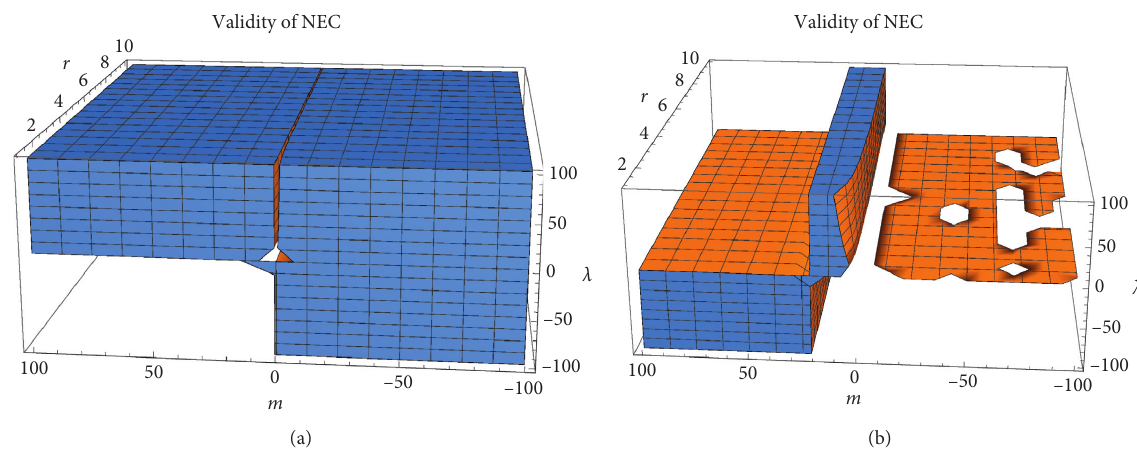
Figure 3: Taking α > 0 , c > 0. The left plot shows the feasible regions of NEC-2 ( ρ + p while the right plot indicates viability regions of NEC-2 ( ρ + p t ≥ 0 ) for β <